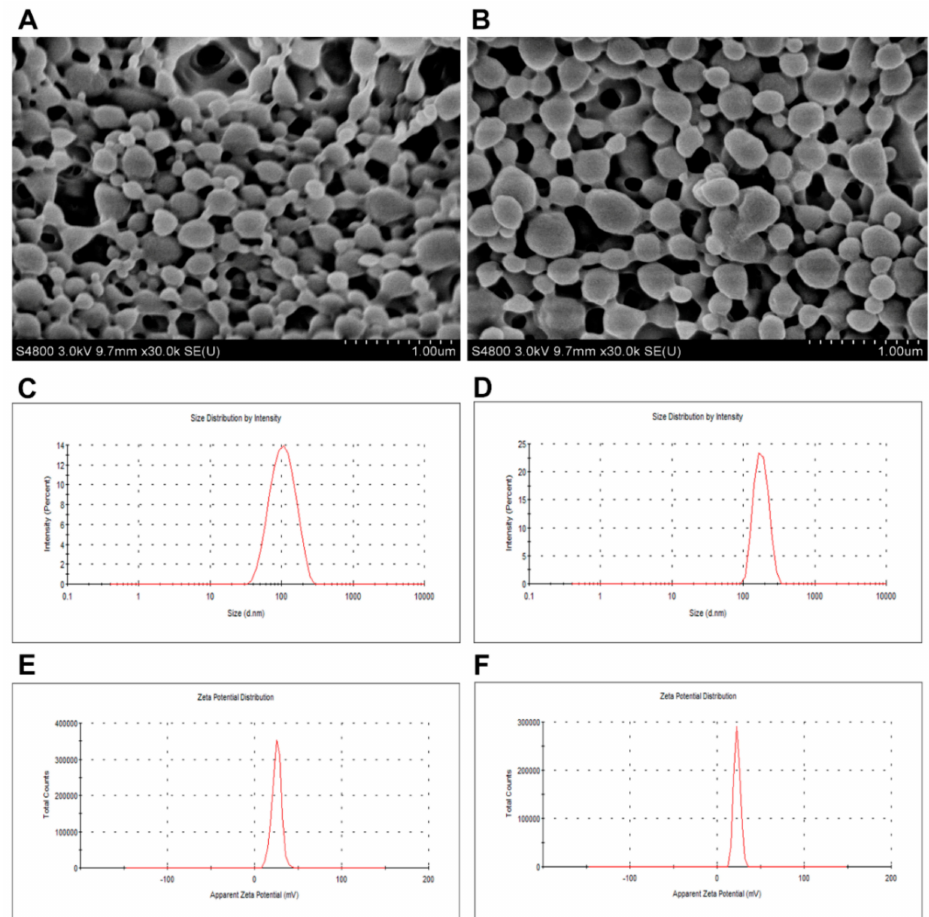
Figure 1. The morphology of nanoparticles was identified by scanning electron microscope ( A , B ). Particle size distribution ( C , D ) with a zeta potential of antigen-loaded poly (( D ), L-lactide-co-glycolide) (PLGA) and chitosan (CS) NP ( E , F ) were also determined in the